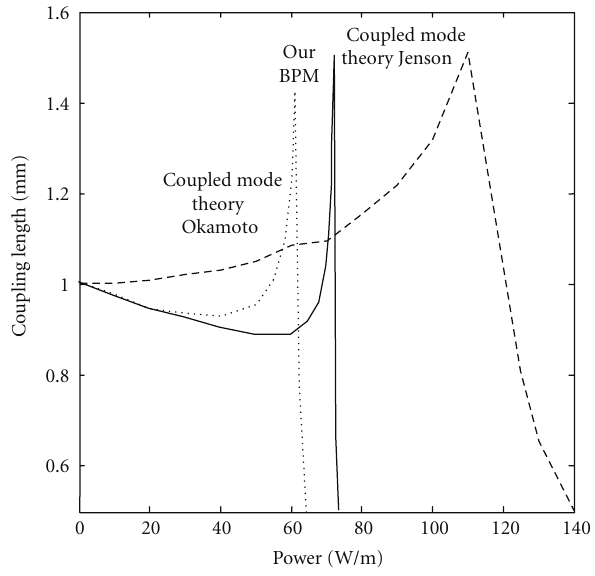
Figure 2: Comparison of coupling length variation with power: coupled mode theory 1 (Jenson): dashed curve, coupled mode the- ory 2 (Okamoto): dotted curve, our BPM simulation: solid curve.